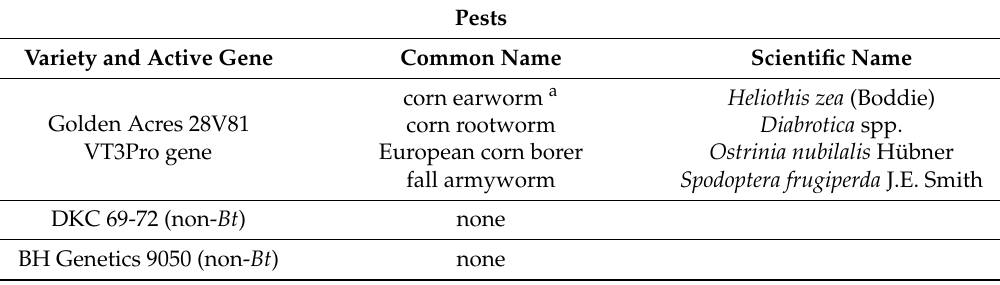
Table 3. Bt maize varieties and the pests against which they are registered [151].